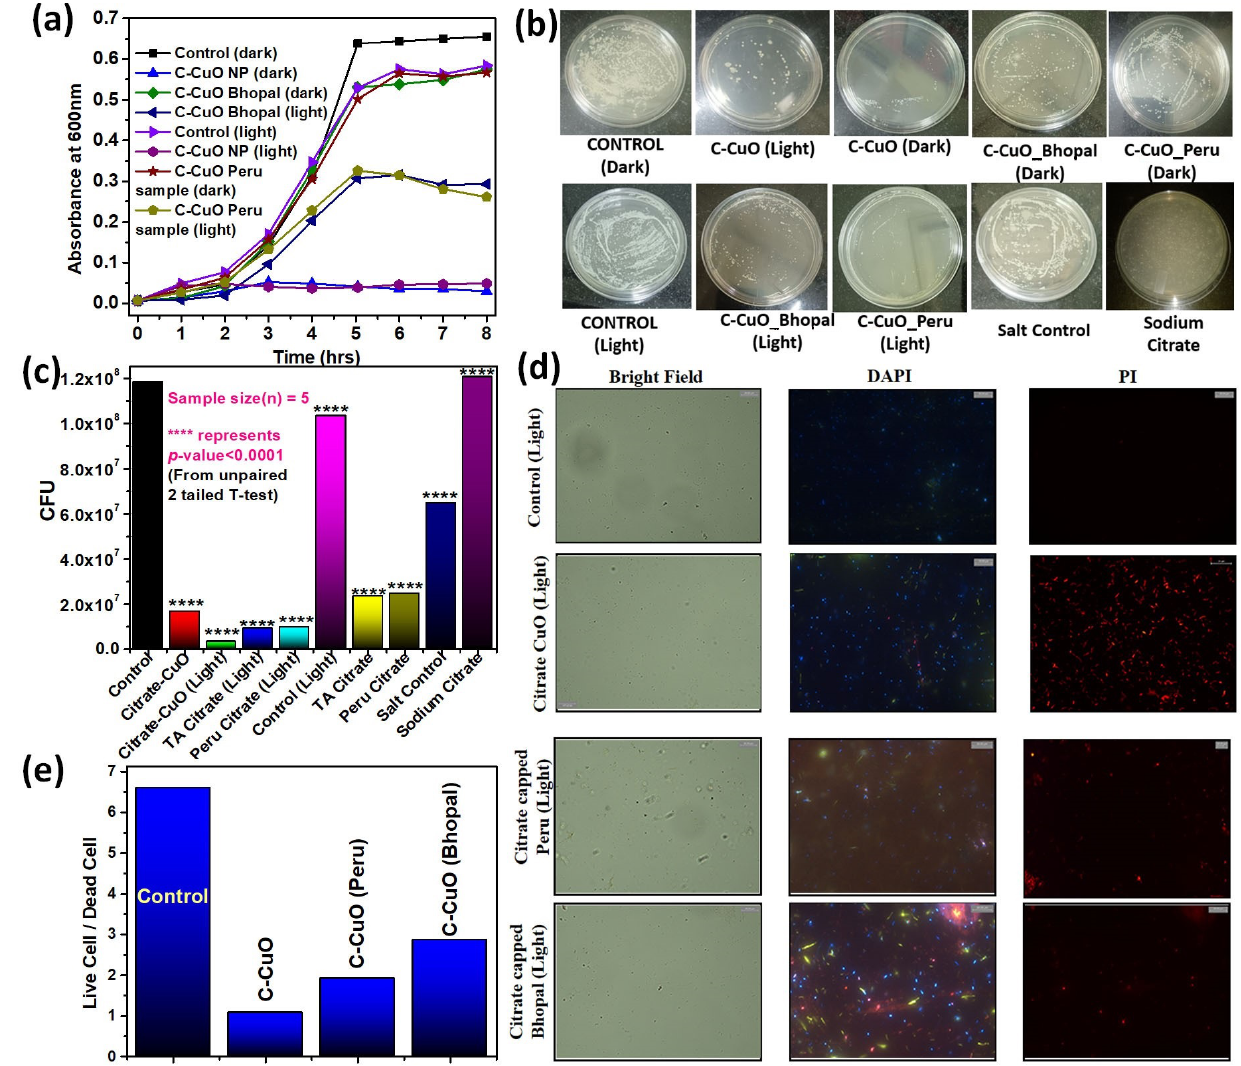
Figure 4. ( a ) Effect of C-CuO NPs on the growth curves of S. hominis bacteria under dark and illumination conditions. ( b ) Bacterial viability after treatment with different citrate CuO NPs in the presence and absence of light irradiation. ( c ) Agar plate colony count assay. ‘****’ indicates p - value < 0.0001. ( d ) Bright-field microscopic images and fluorescence micrographs of bacteria stained with DAPI, and fluorescence micrographs of bacteria stained with PI. ( e ) The ratio of live and dead cells obtained from microscopy.